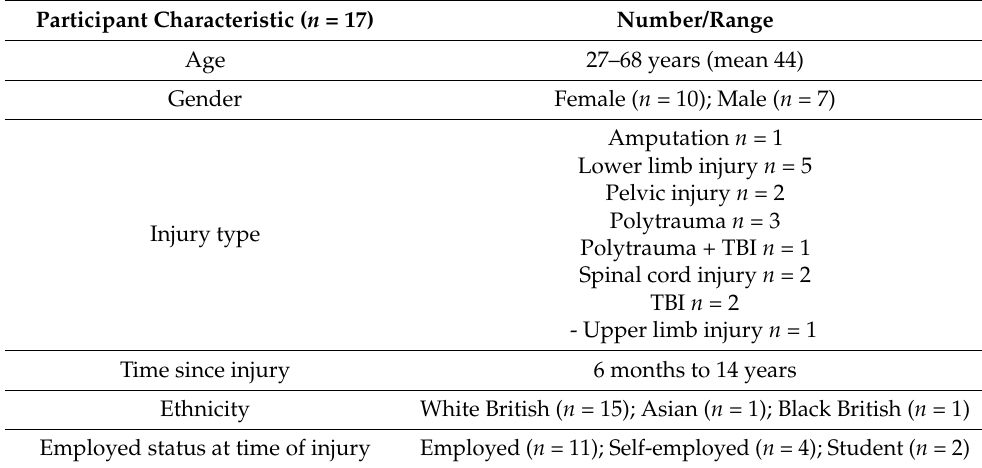
Table 1. Summary of trauma survivor participant